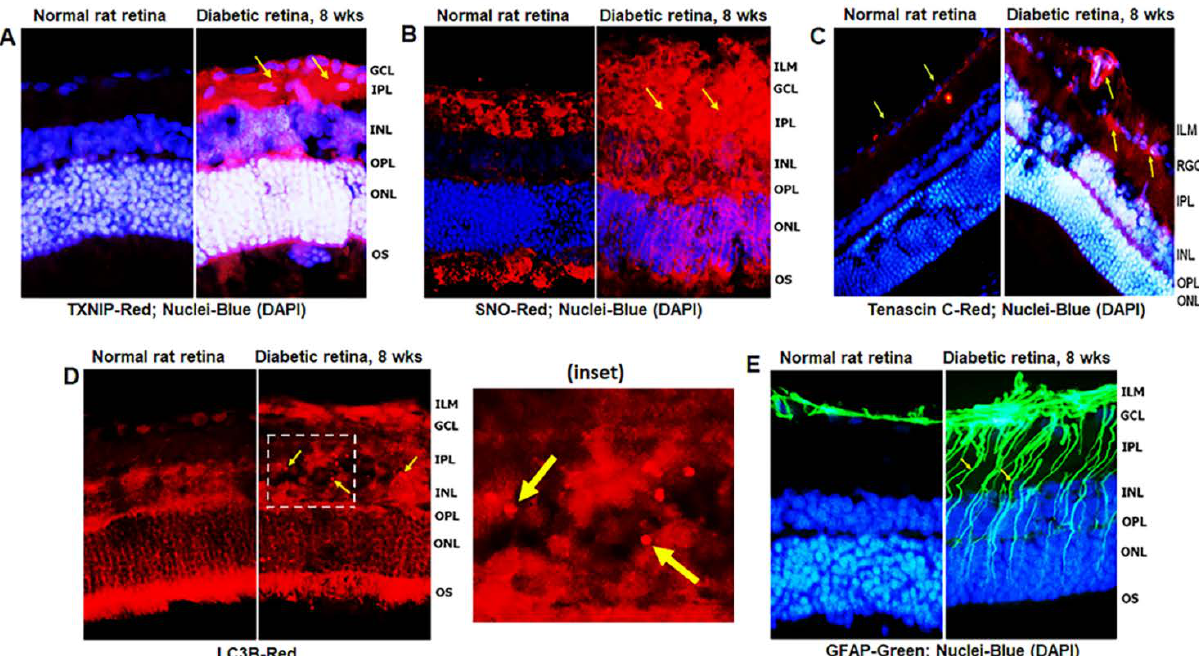
Figure 2. TXNIP expression and redox stress in the diabetic rat retina. ( A ) At 8 weeks of diabetes duration, TXNIP is strongly induced in the diabetic rat retina when compared to the non-diabetic normal rat retina. ( B ) TXNIP expression is associated with increases in protein-s-nitrosylation (SNO), an indication of retinal redox stress in diabetes, and ( C ) expression of extracellular matrix protein, tenascin C, in capillary basement membrane and GCL, suggesting vascular inflammatory response. ( D ) Diabetes also increases autophagosome punctate (arrows in inset) in the retina than in normal rats. ( E ) Müller cell activation (gliosis) is observed in the diabetic rat retina, as indicated by the expression of radial glial fibrillary acidic protein (GFAP), suggesting retinal injury and/or abnormalities in the diabetic retina. The images represent n = 3, taken by an Olympus BX51 fluorescence microscope at 400× magnification.